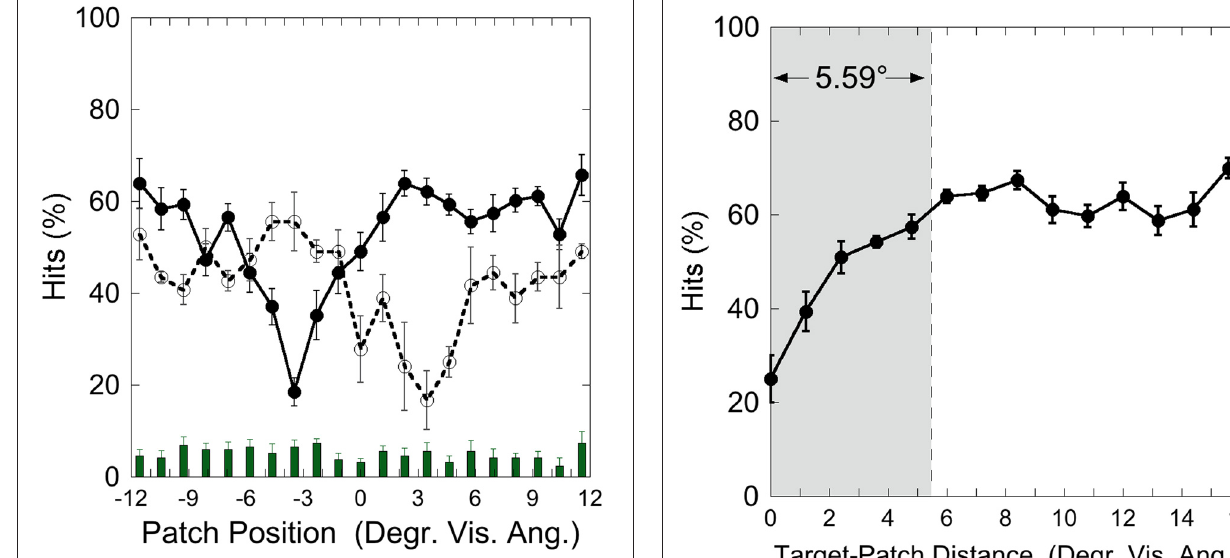
FIGURE 3 | Experiment 1: hits as a function of target-patch distance, averaged over the Red Target and Green Target condition. The gray field represents the critical distance (averaged over participants). Black bars depict standard